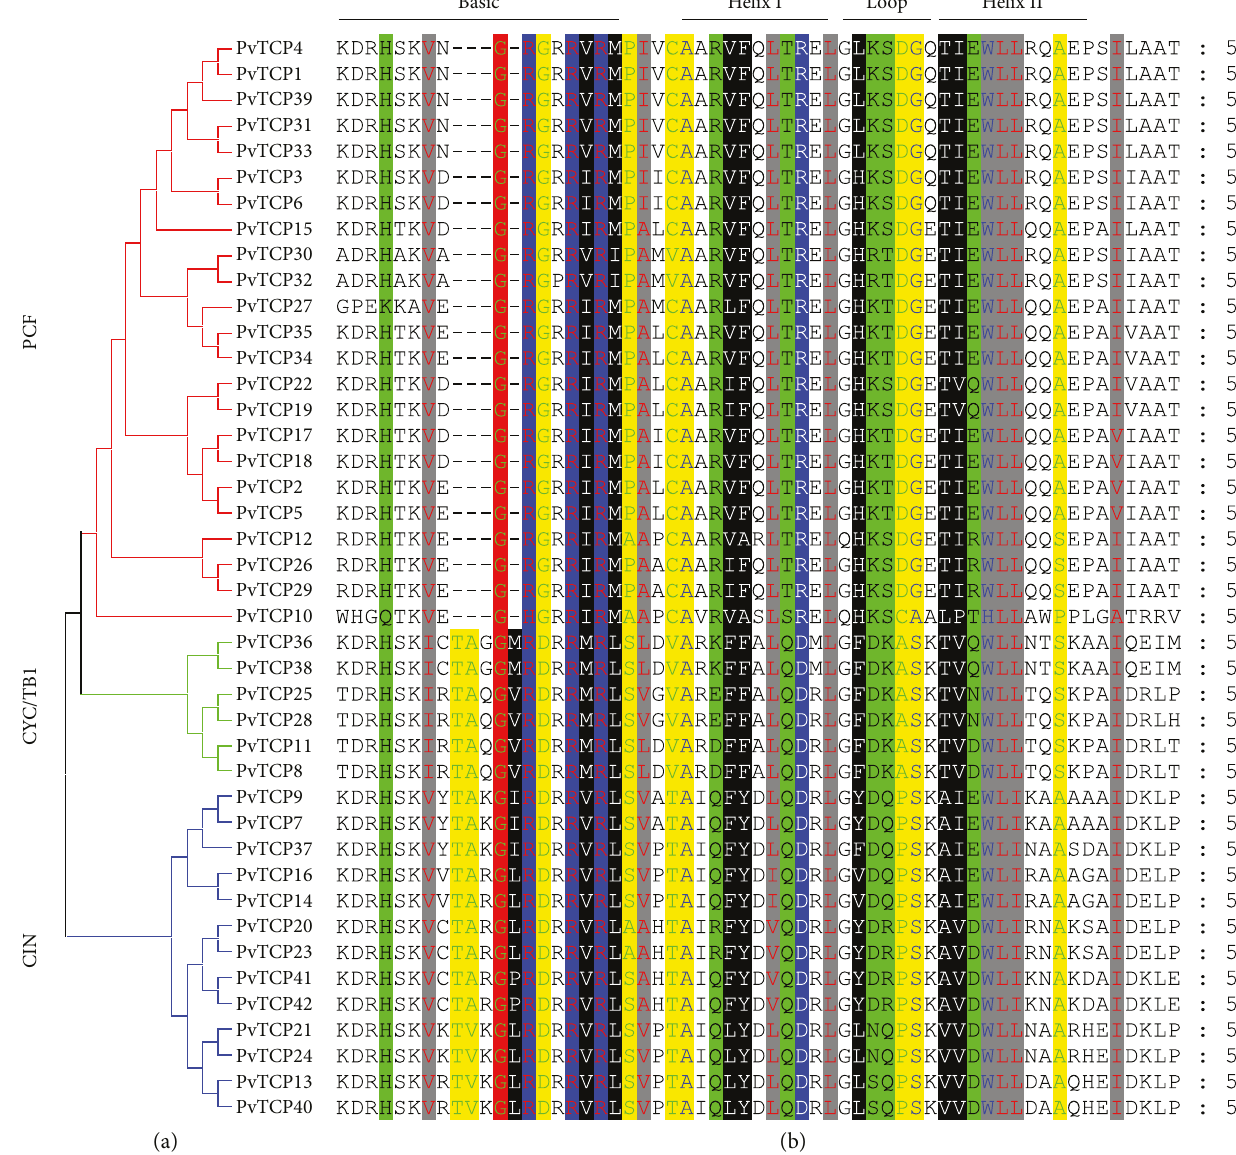
Figure 3: Alignment of the predicted conserved basic helix-loop-helix domain sequence of switchgrass TCP members. Amino acids are expressed in the standard single-letter code. (a) Three clades were classi fi ed according to an unrooted NJ tree, which were constructed using PvTCP peptides. (b) Multiple sequence alignment was generated by